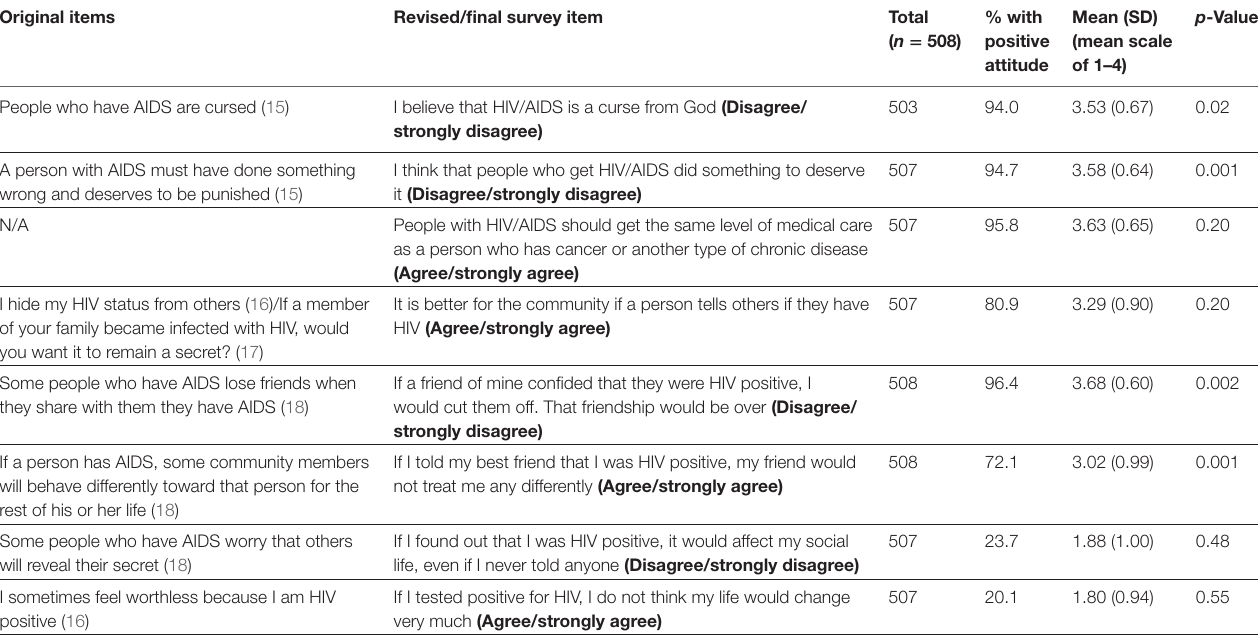
tABle 2 | Derivation of HIV-related stigma items and descriptive statistics.